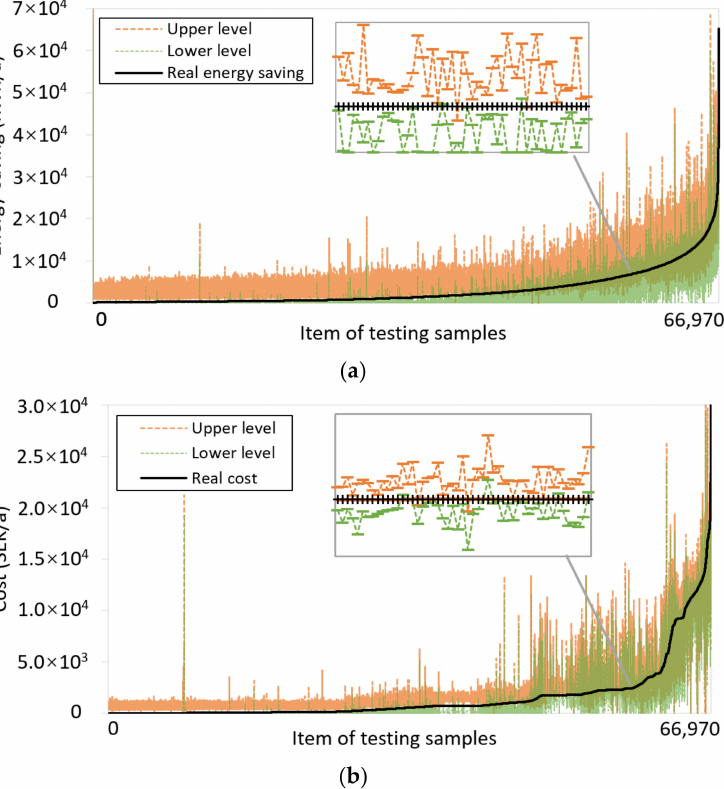
Figure 5. Modelling of energy-savings and cost for EPC testing samples: ( a ) energy-savings for testing samples (accuracy 90.9%) and ( b ) cost for testing samples (accuracy